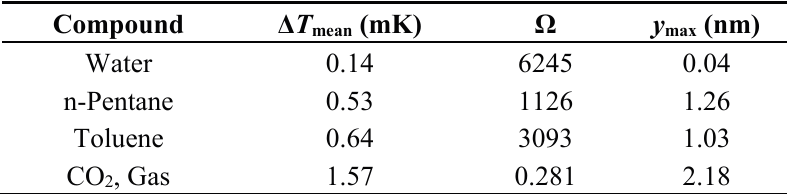
Figure 17. Maximum central deflection, y max , of a circular membrane at t = 0.5 s as function of factor Ω for a water-filled and CO 2 -filled cavity. IR power density of 10 W/m 2 , diameter and height of the cavity: 0.5 mm. Table 5. Comparison of the mean temperature increase Δ T mean , the factor Ω and the maximum deflection of y max of the membrane due to different liquids and CO 2 gas after 50 ms irradiation of 10 W/m 2